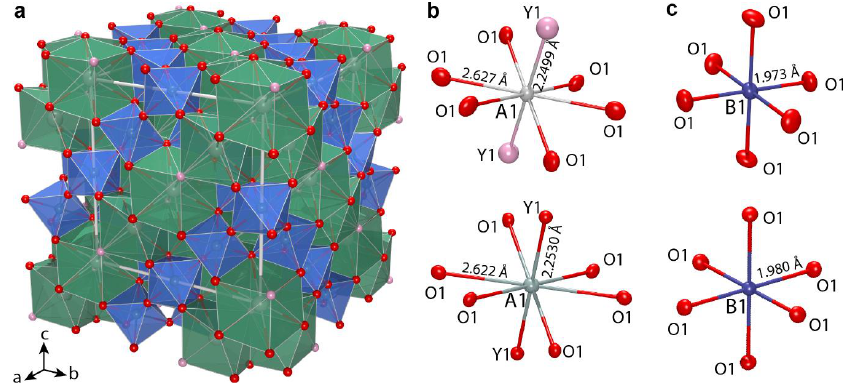
Figure 10. General view of hydroxynatropyrochlore K-017-4 crystal structure ( a ) and geometry of the coordination polyhedra in the crystal structures of hydroxynatropyrochlore K-017-4 ( b ) and oxycalciopyrochlore 917/318.5 ( c ). A O 8 polyhedra are green, B O 6 octahedra are blue, oxygen sites are represented by red circles, Y 1 sites are shown as pink circles.